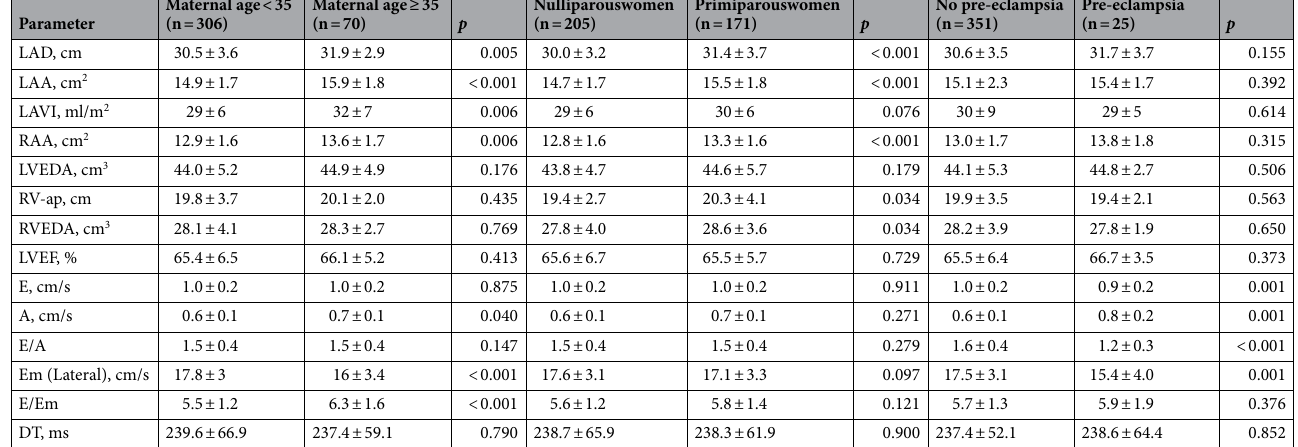
Table 2. Baseline echocardiographic parameters. Values are given as mean ± standard deviation, median (interquartile range) or count (percentage). LAD left atrial diameter, LAA left atrial area, LAVI left atrium volume index, RAA right atrial area, LVEDA left ventricular end-diastolic area, LVEDD left ventricular end- diastolic dimension, RV-ap right ventricular anteroposterior diameter, RVEDA right ventricular end-diastolic area, LVEF left ventricular ejection fraction, E mitral inflow early diastolic velocity, A mitral inflow late filling wave velocity, Em peak early diastolic myocardial velocity, DT deceleration